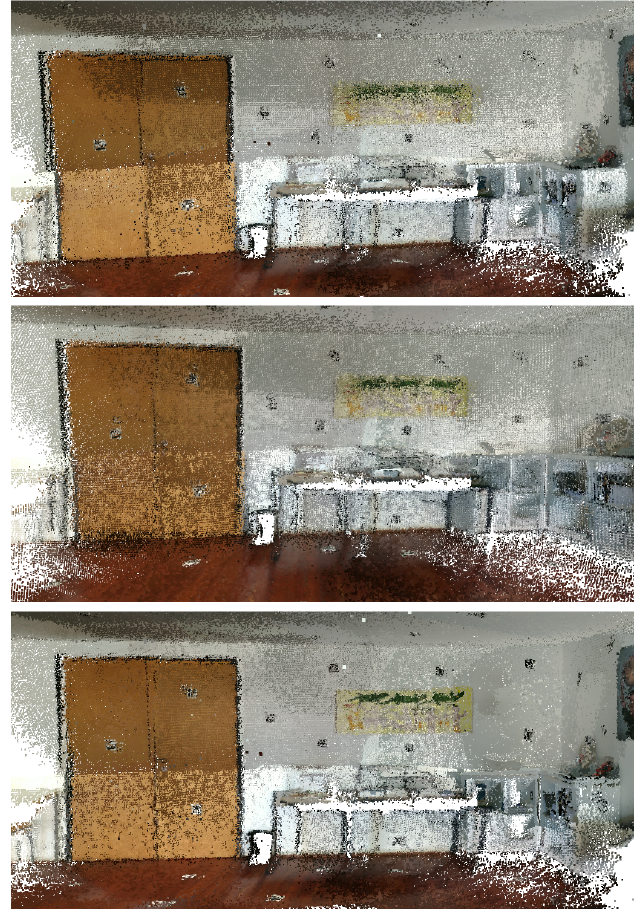
Figure 21. MeetingRoom dataset coloured with texture obtained from original images (detail 2): ( top ) Google Tango; ( middle ) ICP; ( bottom ) Our